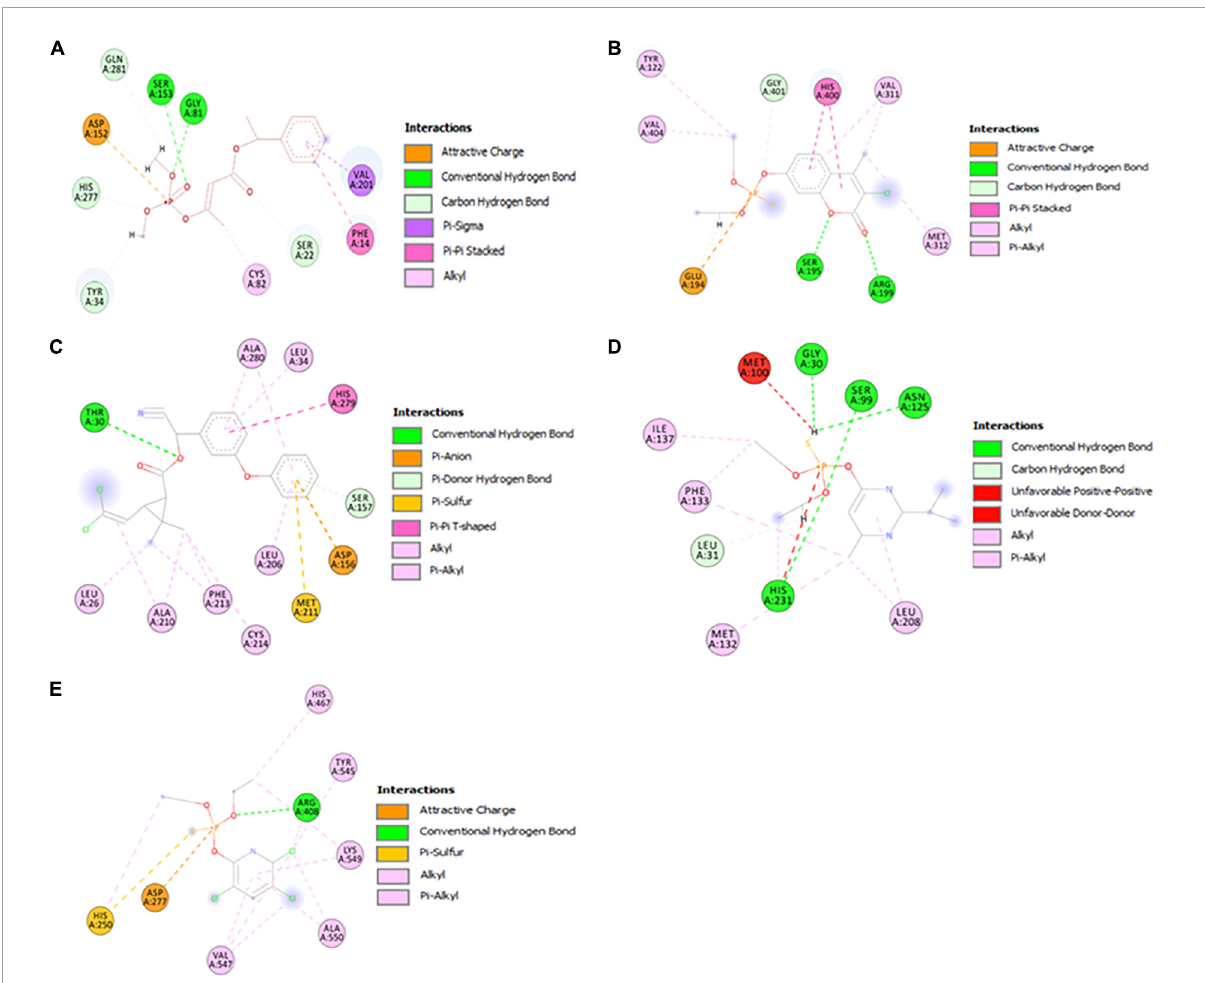
FIGURE6 Visualization of the catalytic interactions of potential model proteins with pesticides. (A) α / β hydrolase (GM298_18675) with crotoxyphos, (B) carboxylesterase with coumaphos, (C) alpha/beta fold hydrolase (GM298_08590) with cypermethrin, (D) alpha/beta fold hydrolase (GM298_00815) protein with diazinon, (E) amidohydrolase family protein (GM298_20245) with